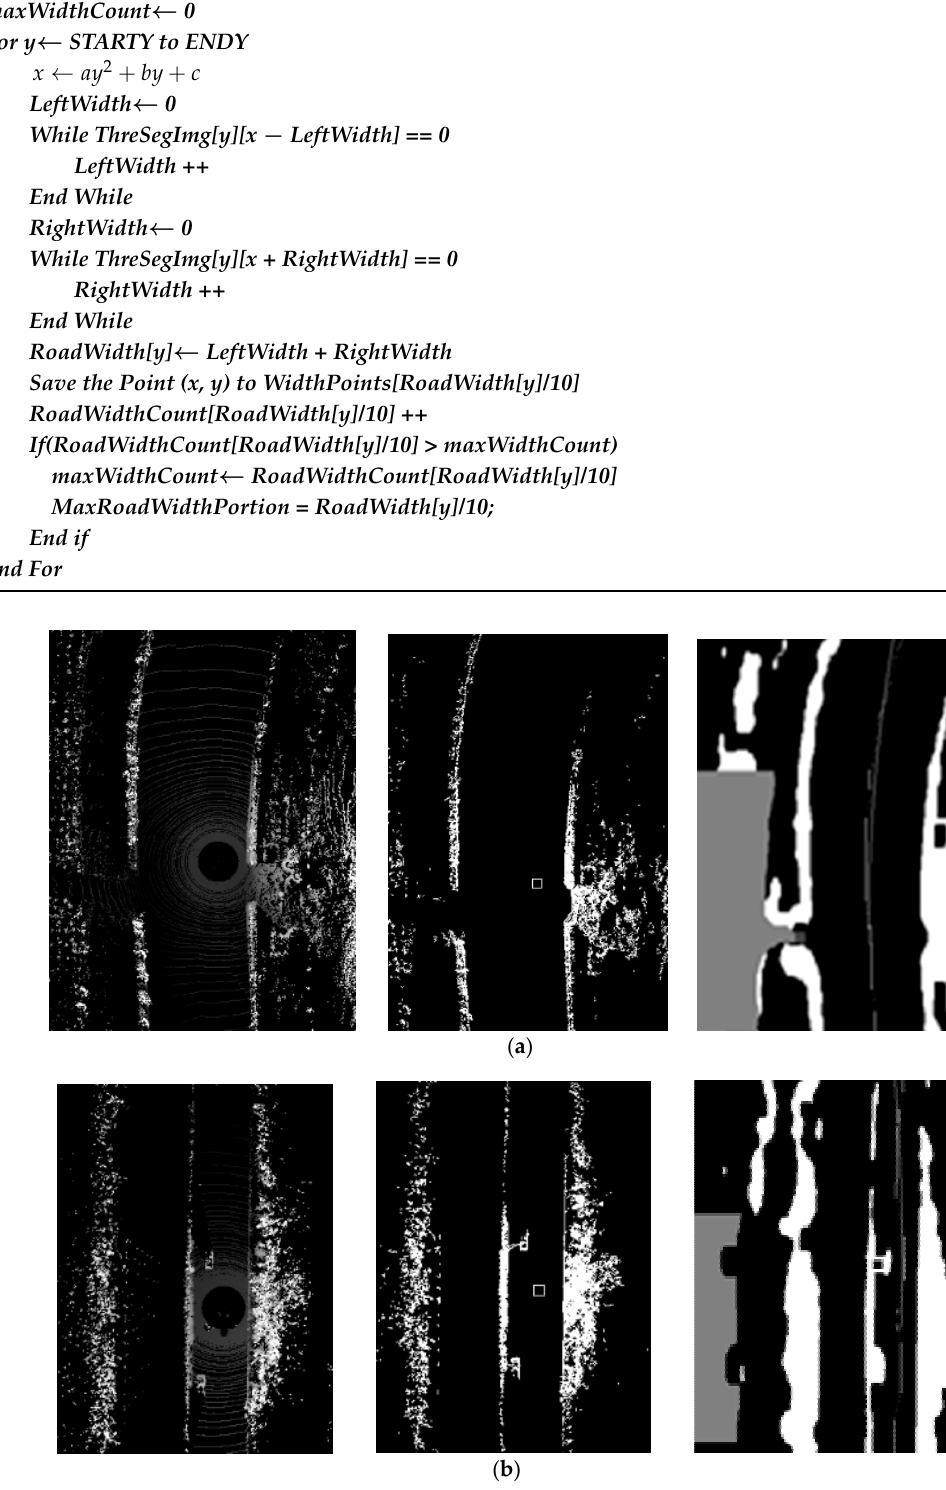
Figure 16. Result of the width distribution in two typical scenes. ( a ) Width distribution of a winding road; ( b ) Width distribution of a straight